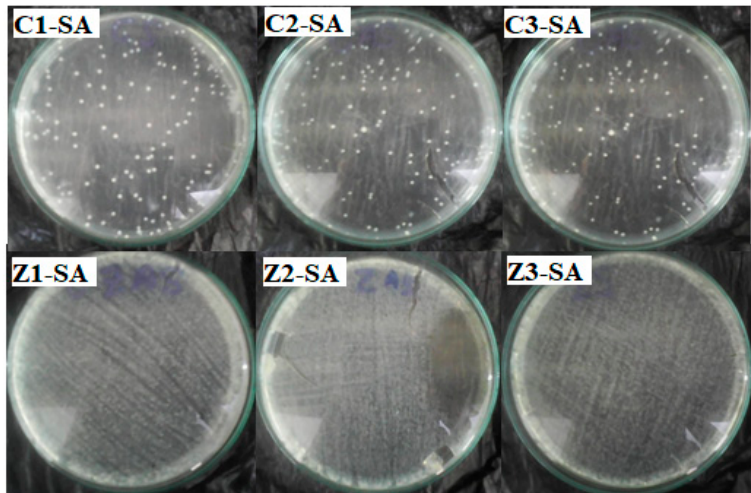
Figure 20. Antibacteria activity of clay/CuO/Ag and clay/ZnO/Ag against S. aureus . C1-EC, C2-EC, C3-EC correspondingly relates to clay/CuO/Ag-1, clay/CuO/Ag-2 and clay/CuO/Ag-3 against S. aureus . Z1-EC, Z2-EC, Z3-EC correspondingly relates to clay/ZnO/Ag-1, clay/ZnO/Ag-2 and clay/ZnO/Ag-3 against S. aureus .